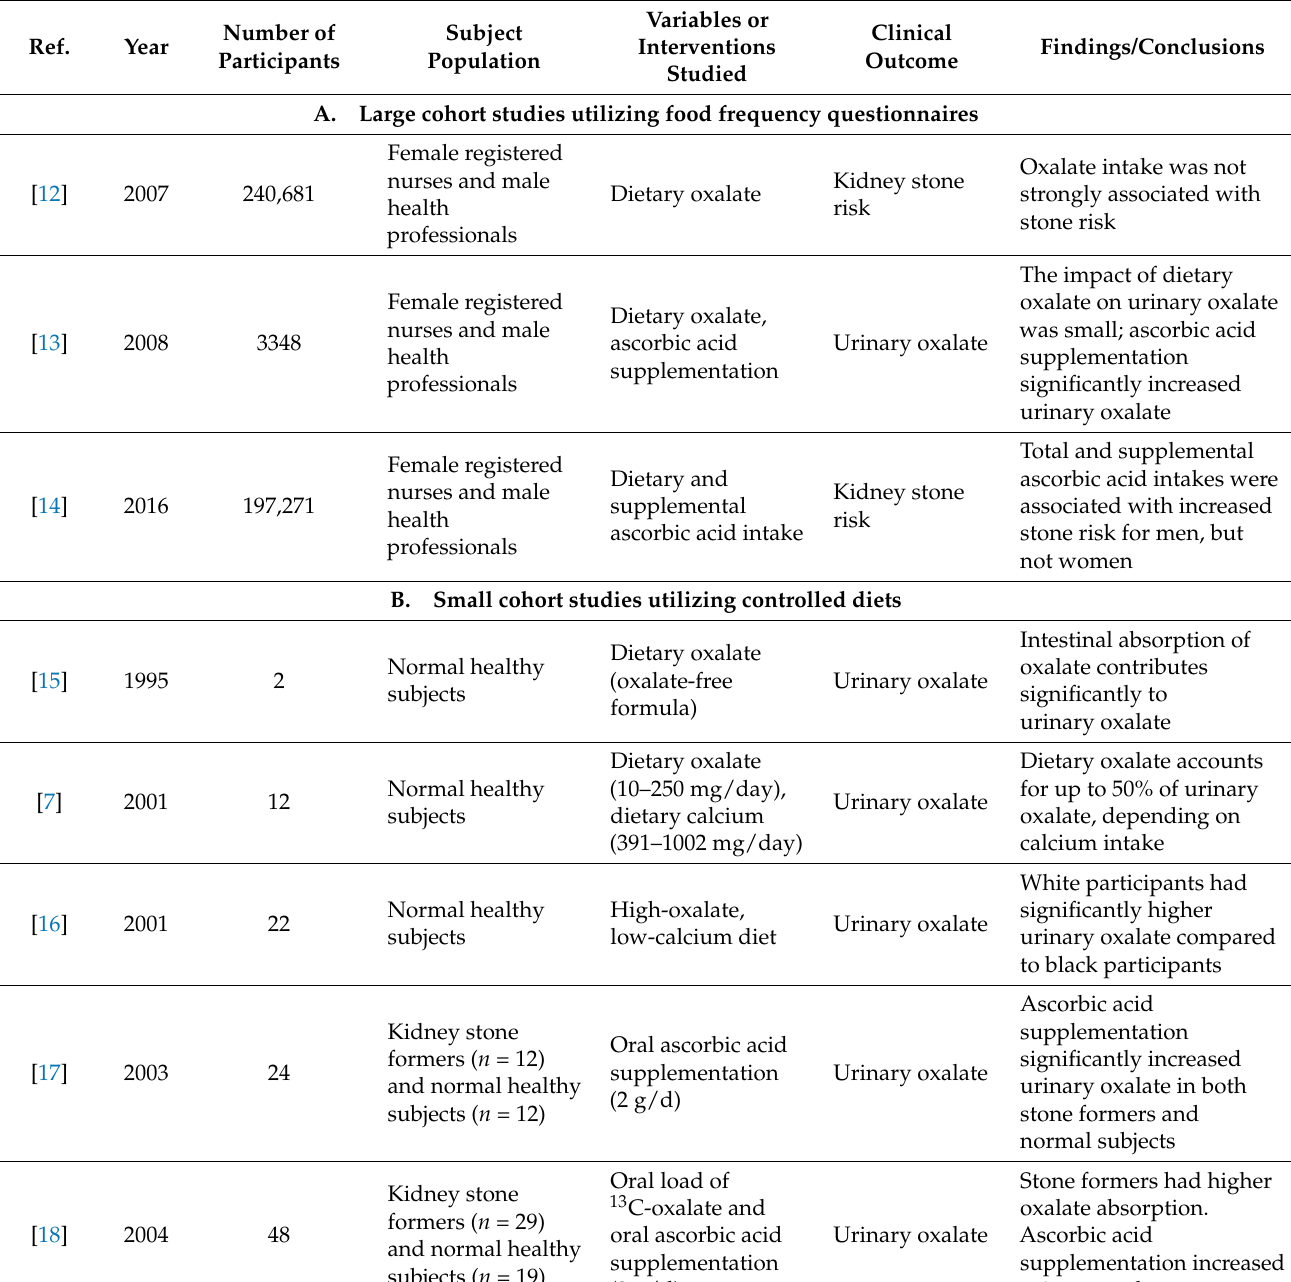
Table 1. Selected studies with methods and clinical outcomes relevant to oxalate assessed through ( A ) food frequency questionnaires in large cohorts or ( B ) dietary control in small cohorts.